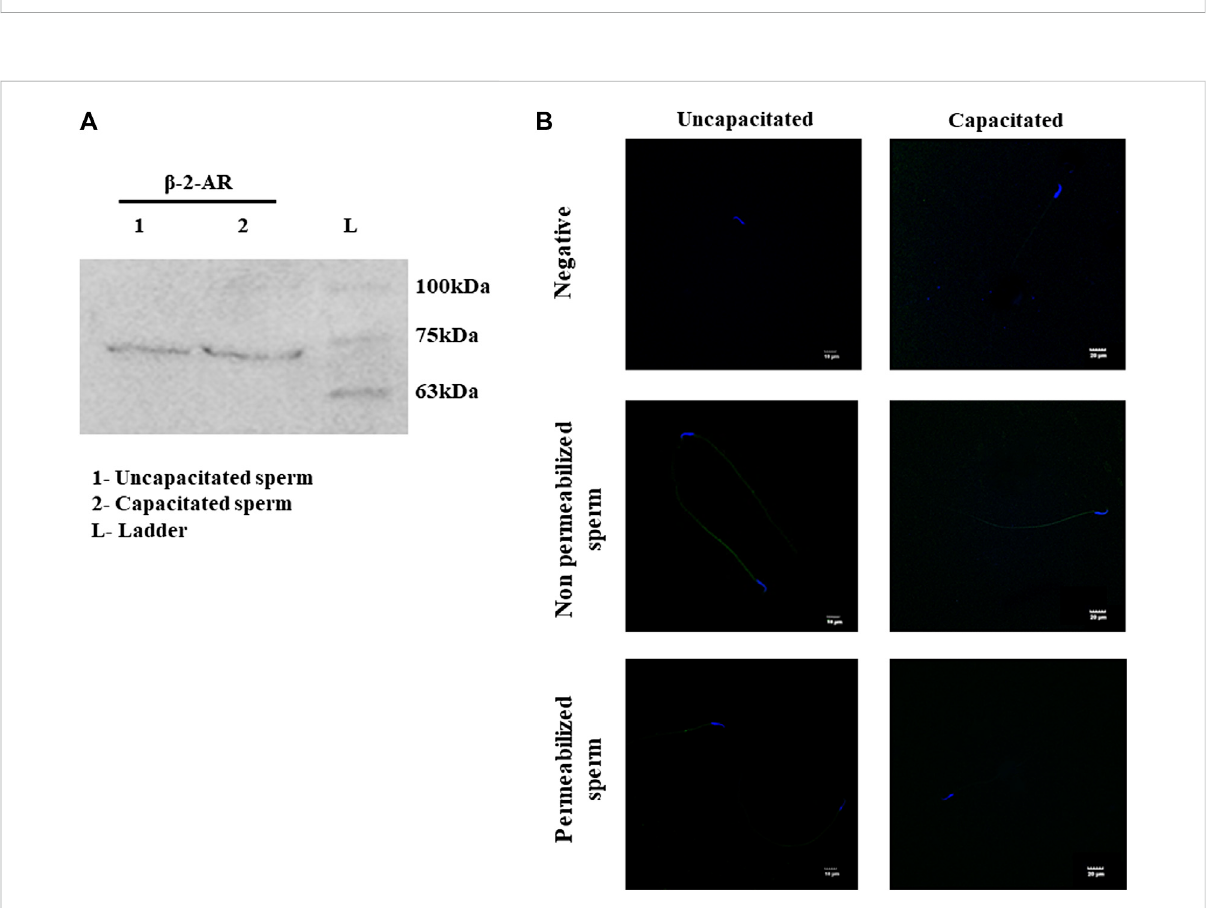
FIGURE 2 Expression and localization of β -2-AR in sperm. Lysates of uncapacitated and capacitated sperm were electrophoresed on 10% SDS PAGE and probed for β -2-AR by Western blot analysis, using antibodies speci fi c for β -2-AR (A) . The complete blots and their ponceau pro fi les are provided in SupplementaryFigureS1.IIFlocalizationshowsthepresenceof β -2-AR(green)inuncapacitatedandcapacitatedintactandpermeabilizedsperm (B) . Nucleiofsperm werestainedwithDAPI(blue). Thenegativecontrolshowsspermincubatedwithonlythesecondaryantibody.Thisexperiment was done in triplicates using sperm from three individual